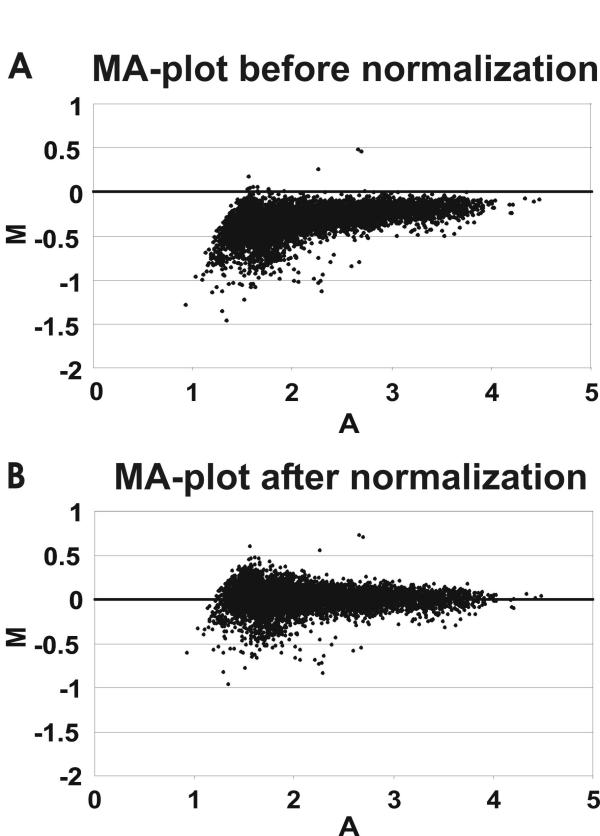
Array and intensity-dependent variation can be corrected by normalization based on intensity. (A) This is an MA-plot before normalization for one of T/C slides that plots the log intensity ratios against the averaged intensities at both wavelengths: M = log (T/C) and A = 1/2log(T*C). The majority of the data is less than zero in a "banana" or "comma" shaped distribution. This demonstrates a systematic, intensity-dependent dye effect, prominent at lower intensities. (B) After normalization using the lowess function, the MA-plot shows a more even distribution at all intensities.